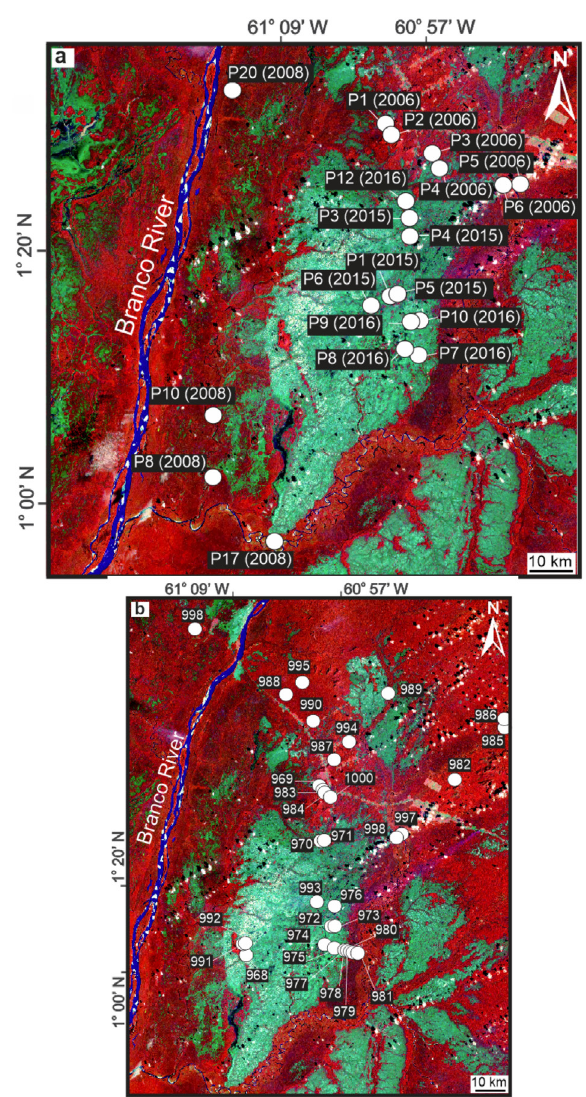
Figure 3 - Floristic inventory plots of trees ( a ) and pteridophytes and Melastomataceae ( b ) in the area of Viruá megafan. Background is an AStEr satellite